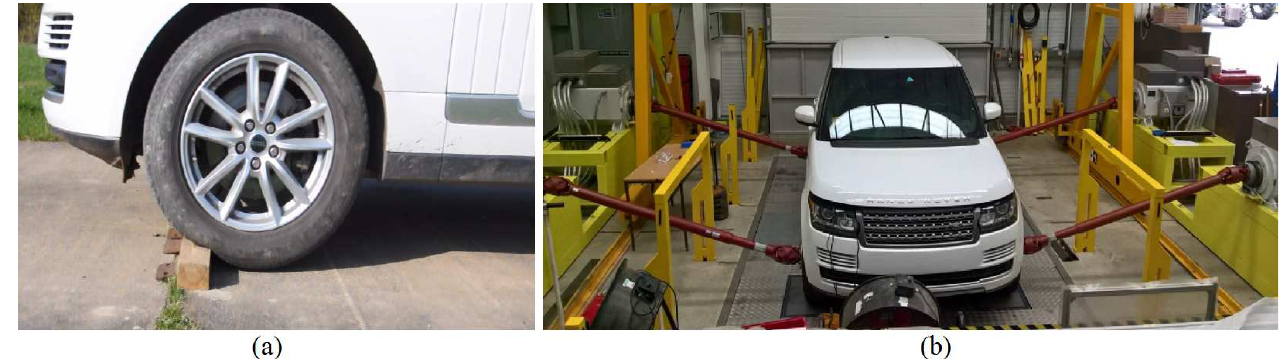
Fig. 15. (a) Vehicle going over a rectangular bump. (b) Vehicle mounted on the ORES test-rig.